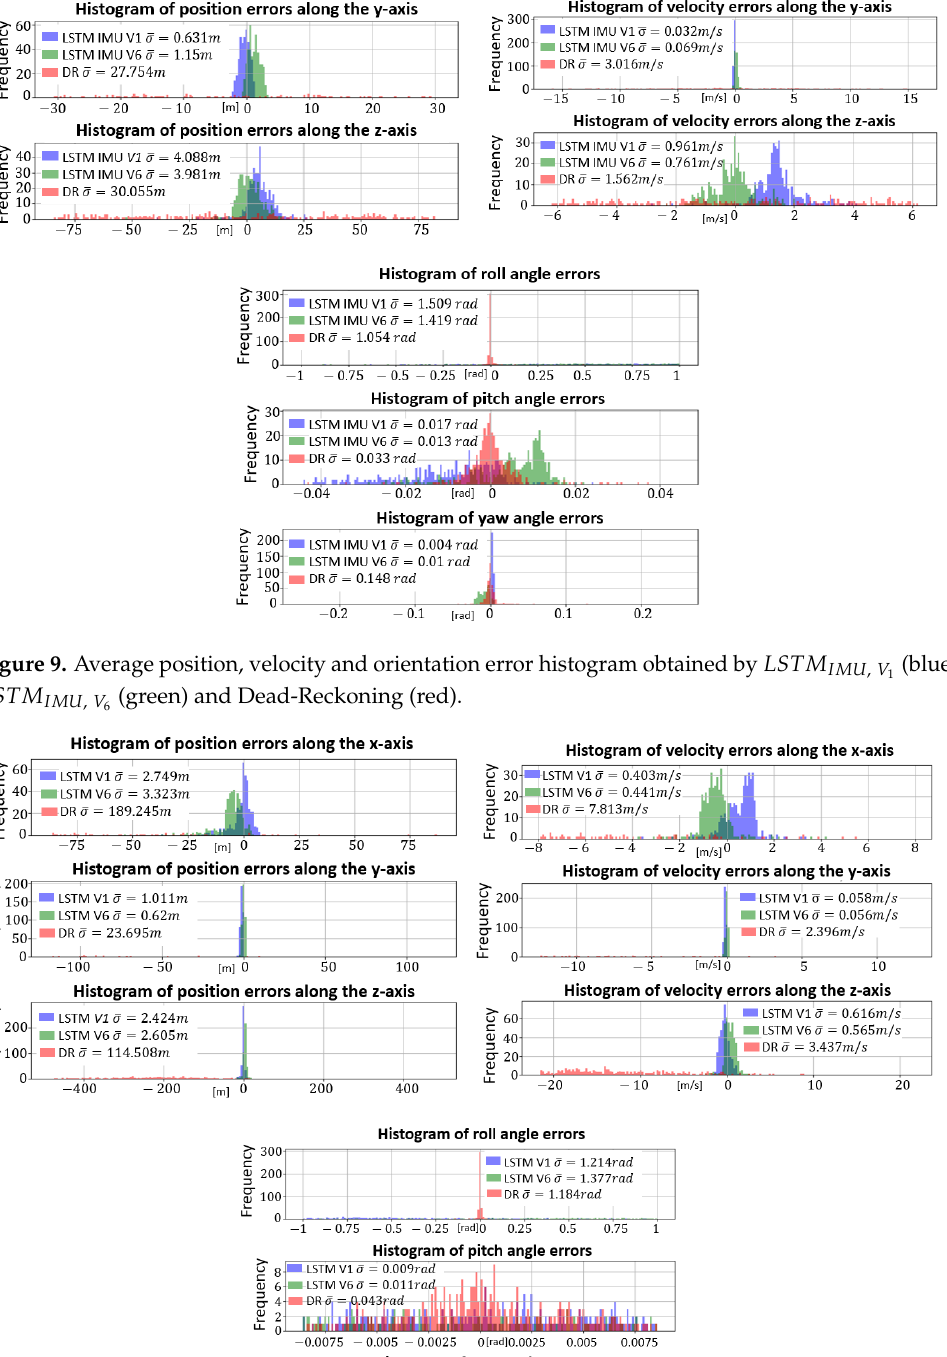
Figure 10. Average position, velocity and orientation error histogram obtained by LSTM IMU DYN , V (blue), LSTM IMU DYN , V (green) and Dead-Reckoning 6